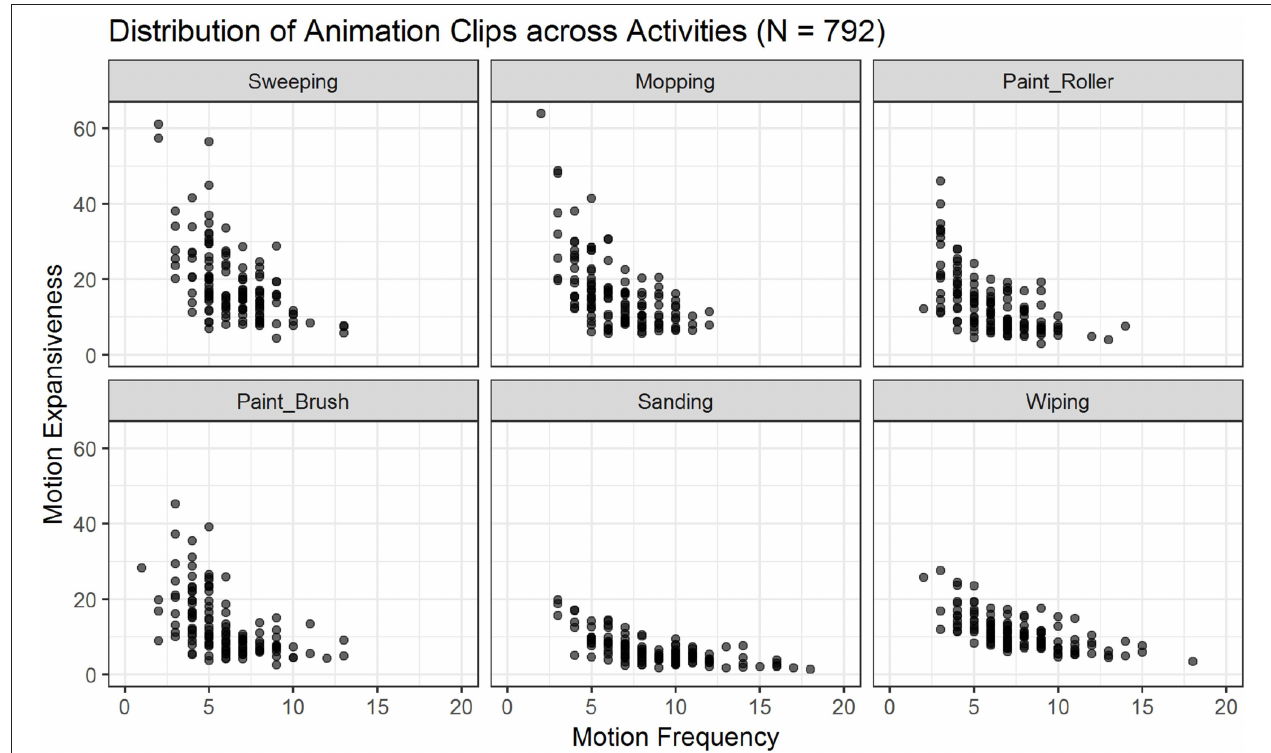
FIGURE 5 | Scatter plots showing the relations of motion frequency and motion expansiveness for all six activities. Darker areas indicate the overlap of multiple animation-files. Sanding and wiping show the highest values for motion frequency, while sweeping, and mopping show the highest values for motion